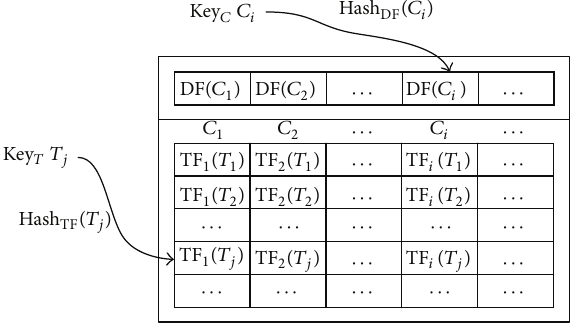
Figure 2: Token level